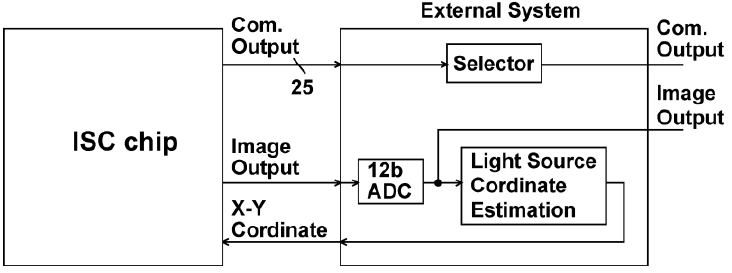
Figure 24. Setup for image data